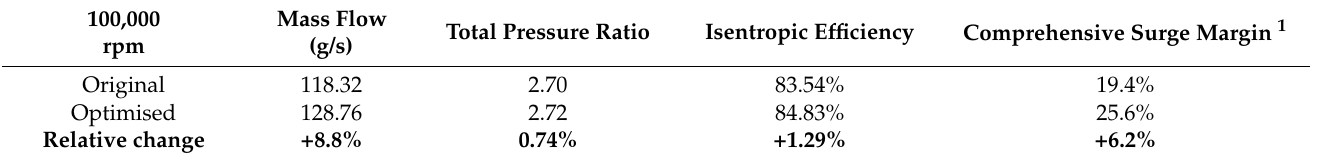
Table 7. Comparison of the performance at the design point before and after optimisation (rated operating condition).